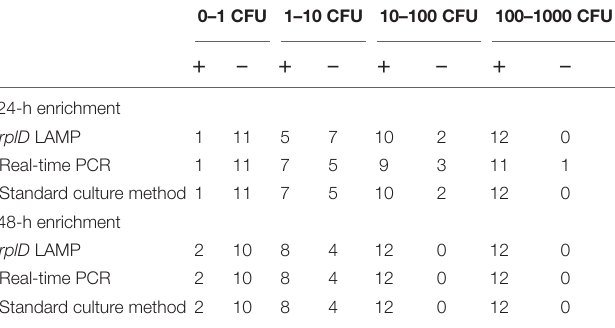
TABLE 3 | Total numbers of positive ( + ) and negative ( − ) results obtained by rplD LAMP, real-time PCR, and the standard culture method, testing artificially contaminated minced meat samples at four inoculation levels after 24- and 48-h